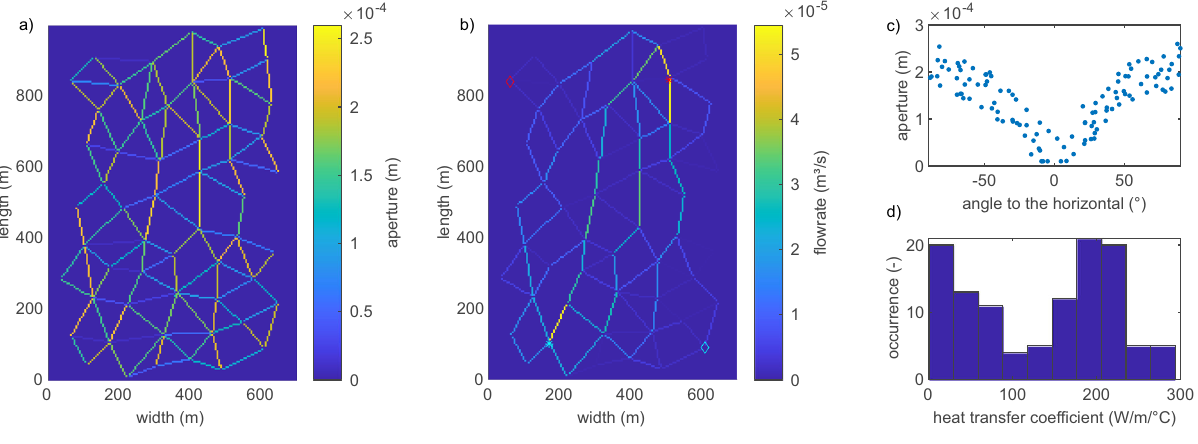
con fi gurations: 1 (asterisks) and 2 (diamonds). The fl ow rate is maximum along preferential fl ow paths within the network ( b ). Aperture varies with fracture